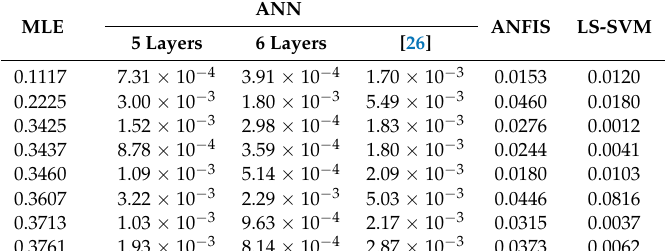
Table 4. RMSE obtained during the validation stage with a six steps ahead prediction horizon. ANN MLE ANFIS